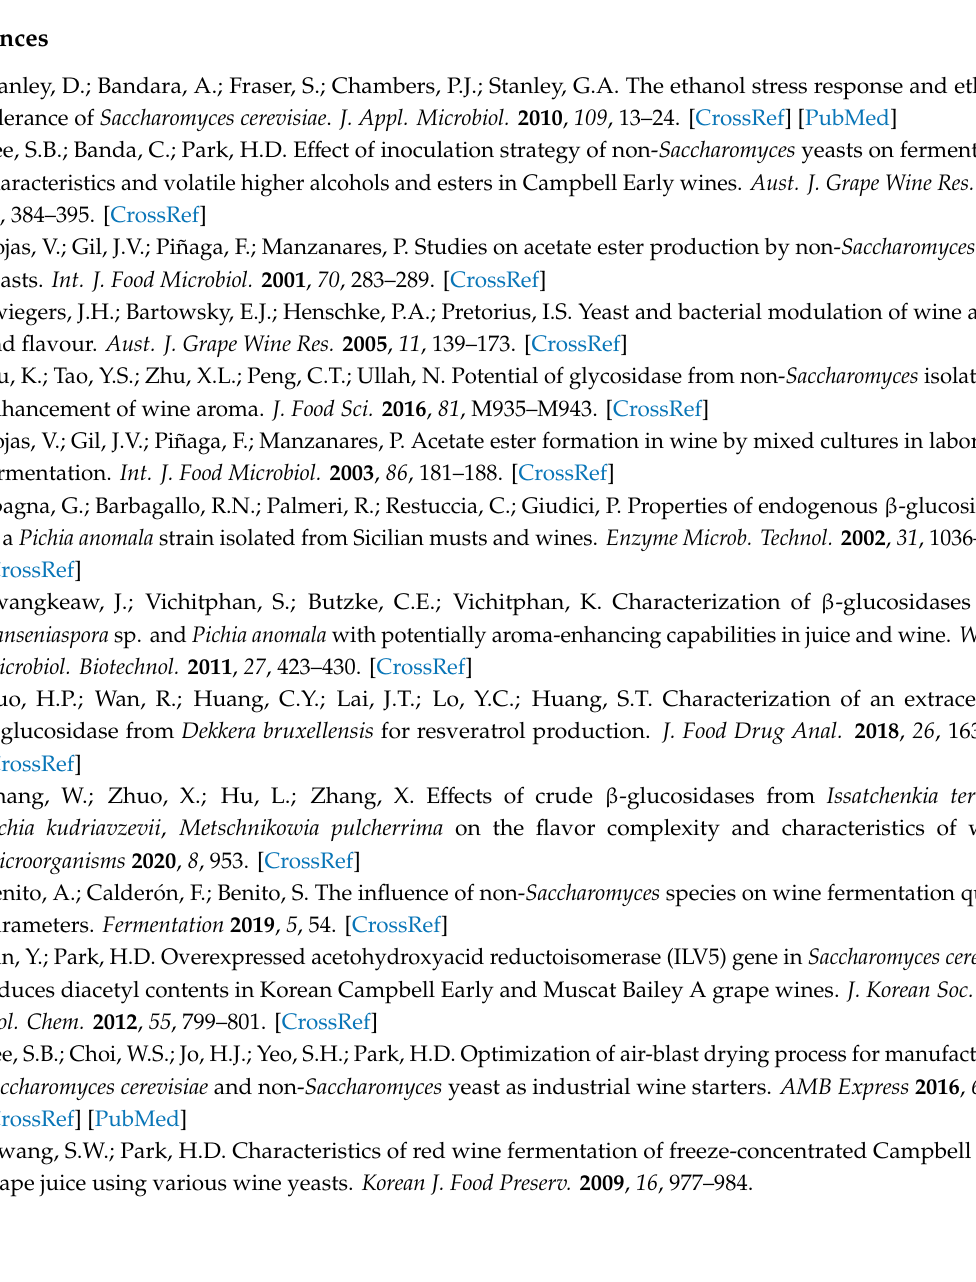
Figure S1: PCR-RFLP analysis of amplified ITS I-5.8S-ITS II region of 84 isolates from S é millon grape (S), persimmon (P), and Muscat Bailey A grape (MR), Figure S2: Fermentation rates of nine non- Saccharomyces yeasts and the control strain Saccharomyces cerevisiae W-3, Table S1: Diversity of yeasts isolated from various food materials such as S é millon grape (S), persimmon (P) and Muscat Bailey A grape